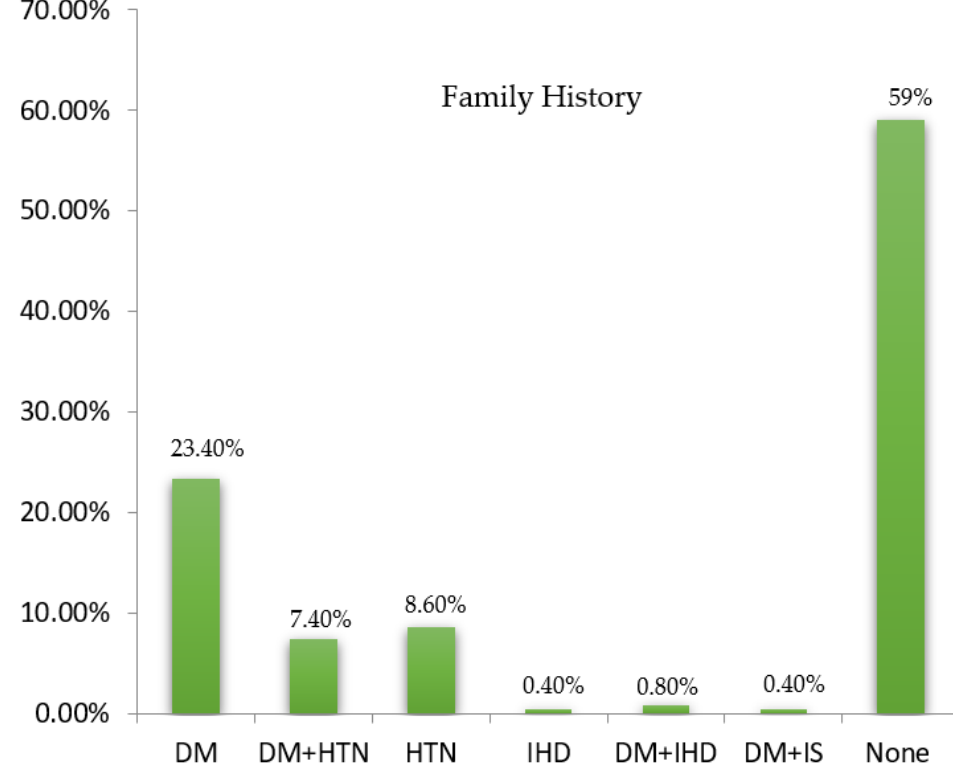
Figure 3. A bar chart illustrating the proportion of subjects with family history.